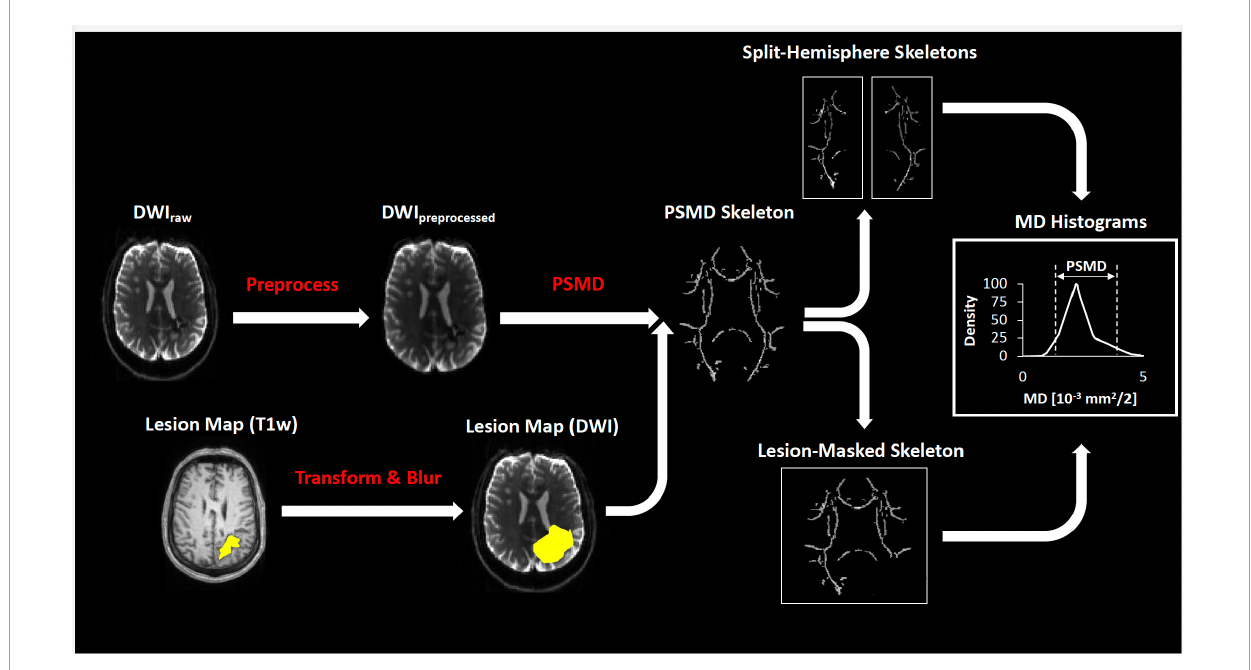
FIGURE1 Diagram of diffusion processing. The preprocessed diffusion scans were co-registered with the lesion mask and processed by the fully automated PSMD tool (see section “Materials and methods”) to calculate peak width of the skeletonized MD histogram.